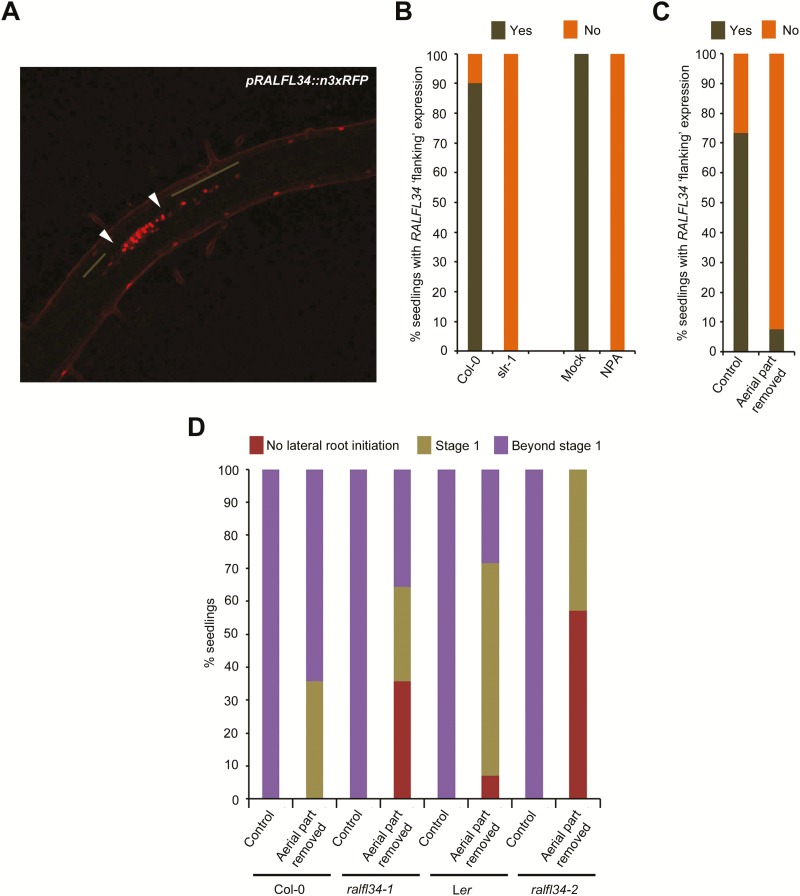

RALFL34 ‘flanking’ expression. (A) Representative image of pRALFL34::n3xRFP expression with expression in the lateral root primordium (between white arrowheads) and flanking the lateral root primordium (brown line) upon bending. (B, C) Percentage of seedlings showing pRALFL34::n3xRFP ‘flanking’ expression in (B) the wild type (Col-0) versus slr and mock (DMSO) versus NPA-treated seedlings upon bending and in (C) seedlings with aerial tissues removed. (D) Percentage of seedlings, with aerial tissues removed, which failed to initiate lateral roots (red), developed a stage 1 primordium (khaki), or progressed beyond stage 1 (purple), 20h post-mechanical bending.